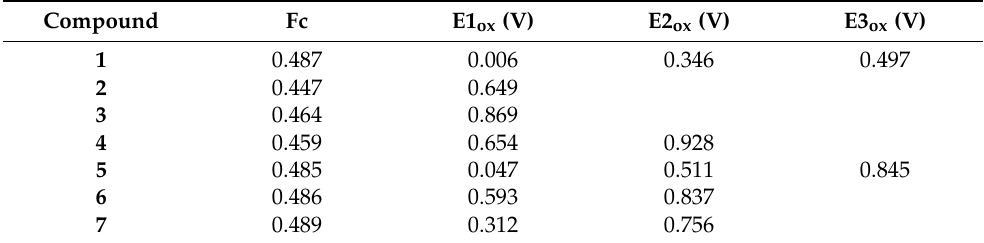
Figure 4. CV plots for compounds 1 (caprolactam ligand and donor Me substituent in catecholate fragments) and 6 (acetamide moiety and acceptor NO 2 substituents in catecholate fragments). Table 2. Cyclic voltammogram data of 1 – 7 recorded in DMSO, 0.1 M TBAPF6 as supporting electrolyte, Ag/AgCl in saturated KCl solution reference electrode, Pt working electrode. C(comp) = 1 mM.